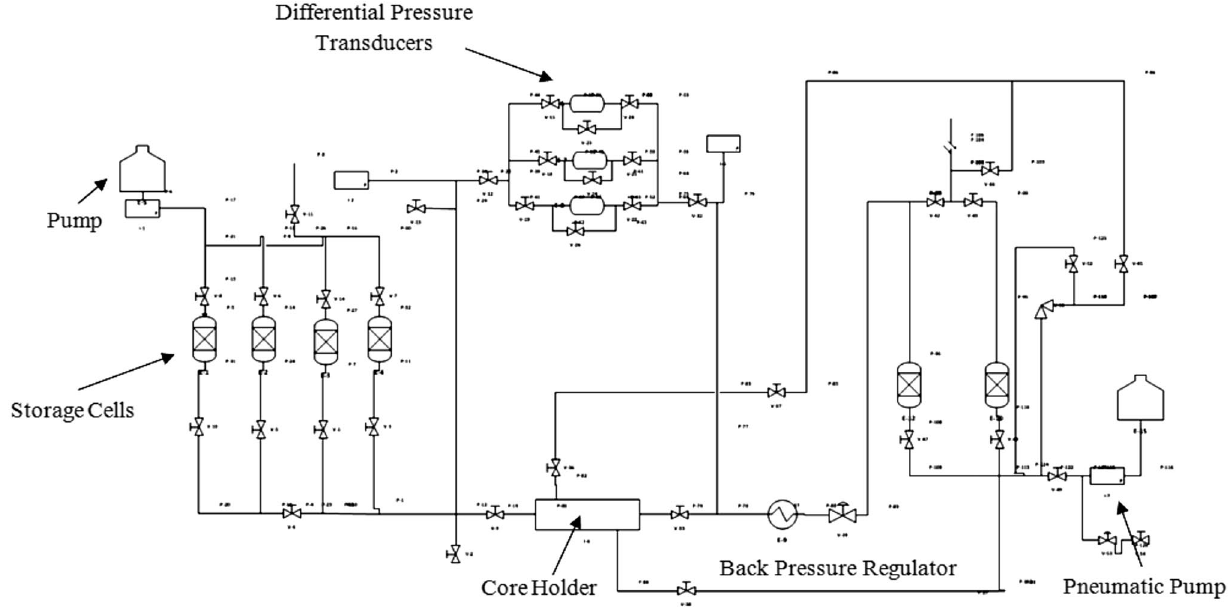
Fig. 2 Schematic of experimental setup used for flooding experiments (Hassani et al. 2014)